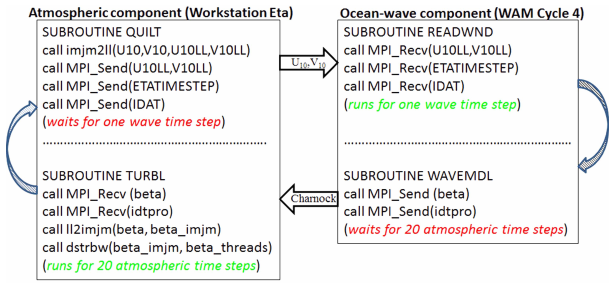
Figure 2. The Mellor–Yamada surface layer with the viscous sub- layer over the ocean. The symbol Z LM is the height of the lowest model layer and Z U is the depth of the viscous sublayer for mo- mentum. (Reproduced from Janji´c, 1994).